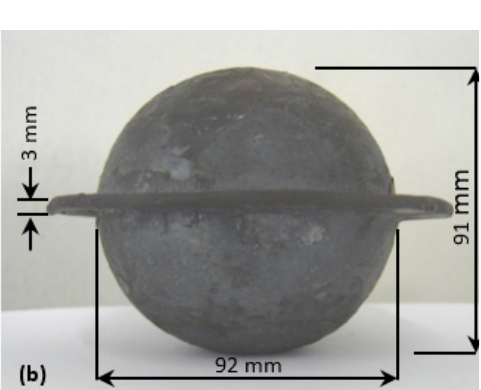
Figure 1. Typical failure mechanisms in hot forging closed dies.